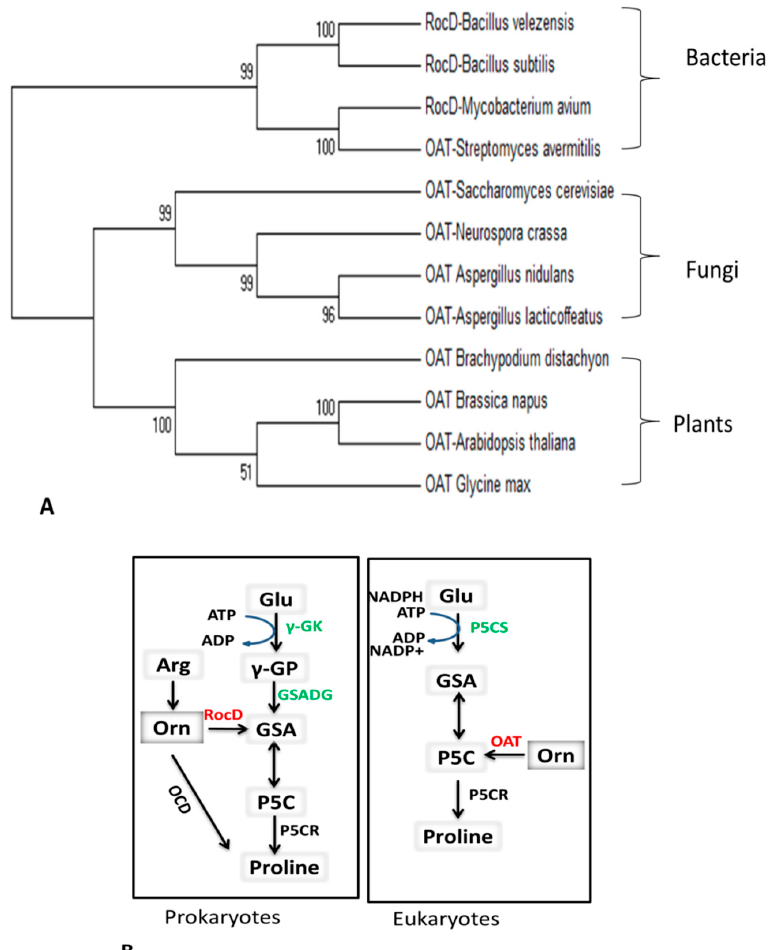
Figure 1. Conservation of the ornithine aminotransferase (OAT) enzyme among prokaryotes and eukaryotes: ( A ) Maximum likelihood phylogenetic tree showing the conservation of OAT enzymes from prokaryotes to higher plants. The tree was constructed using MEGA 6 software with the bootstrap method. Accession numbers of the species used in the study are as follows: Bacillus subtilis (NP-391914.1), Streptomyces avermitilis (Q82HT8), Bacillus velezensis (ABS76054.1), Mycobacterium avium (AAS04411.1), Aspergillus nidulans (Q92413), Saccharomyces cerevisiae (P07991), Neurospora crassa (Q7RX93), Aspergillus lacticoffeatus (XP_025460070), Arabidopsis thaliana (OAO92185), Brassica napus (NP_001303219.1), Glycine max (XP_003531161.1), and Brachypodium distachyon (KQK13994.1). ( B ) Differences in the Glu pathway of Pro synthesis among prokaryotic and eukaryotic organisms. γ -GK: γ -glutamyl-kinase; γ -Glu: γ -glutamyl-phosphate; GSADH: glutamic- γ -semi-aldehyde dehydrogenase.